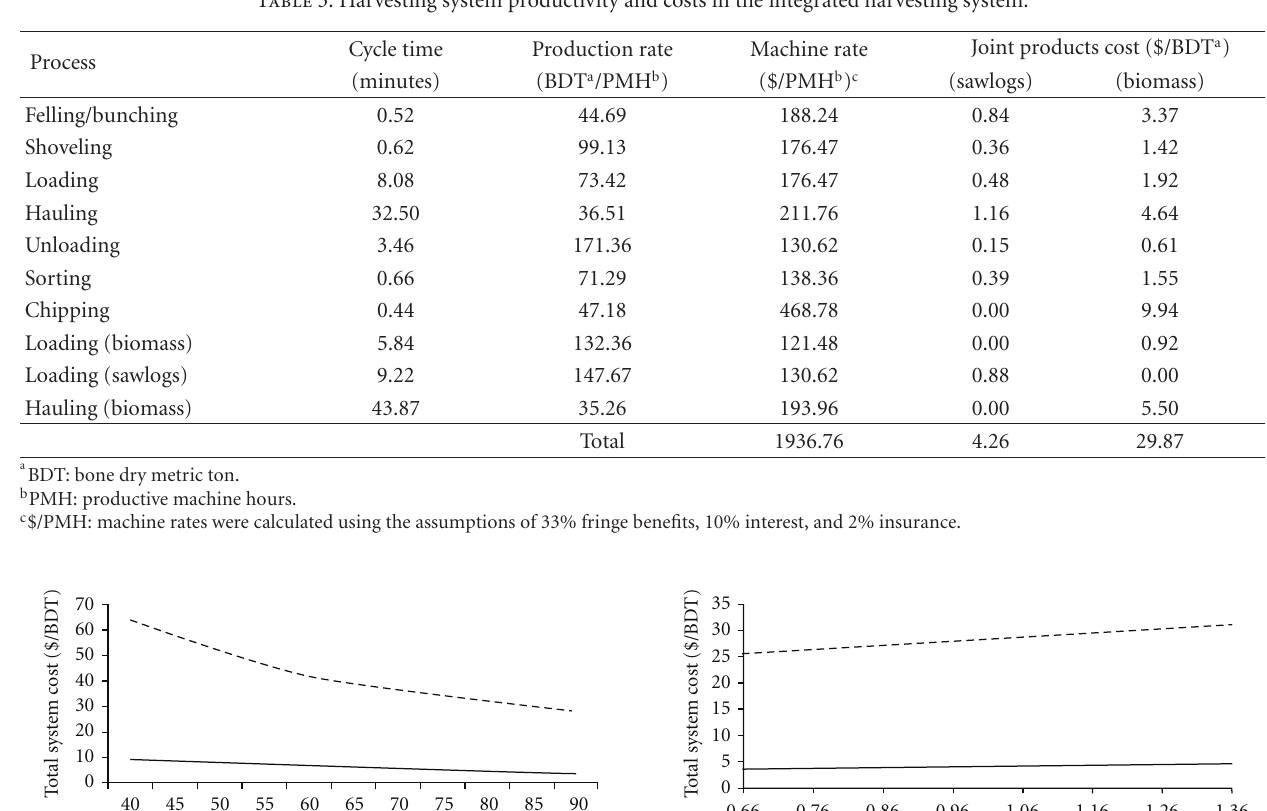
Table 3: Harvesting system productivity and costs in the integrated harvesting system.